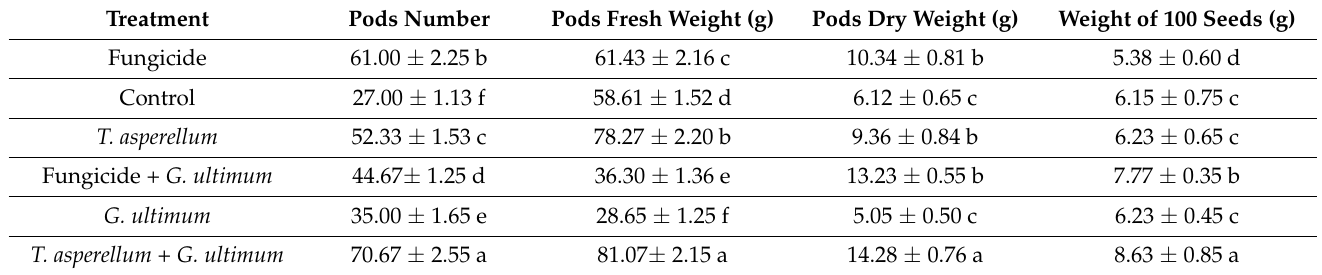
Table 6. Evaluation of T. asperellum ZNW on the yield of pea under infection with G. ultimum .